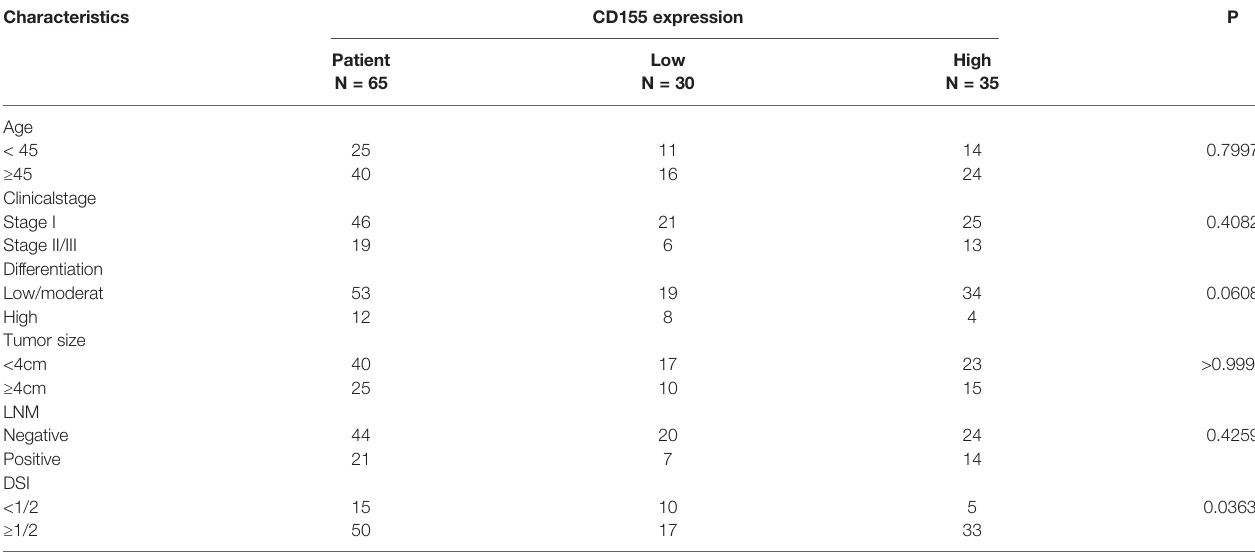
TABLE 1 | Association between CD155 expression and the clinicopathological features of patients with cervical cancer.